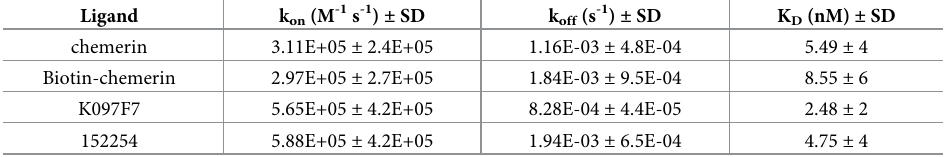
Table 1. Summary of human CCRL2 antibody and chemerin binding to HEK-huCCRL2 cells using live-cell SPRm (n = 3). Ligand k on (M -1 s -1 ) ±